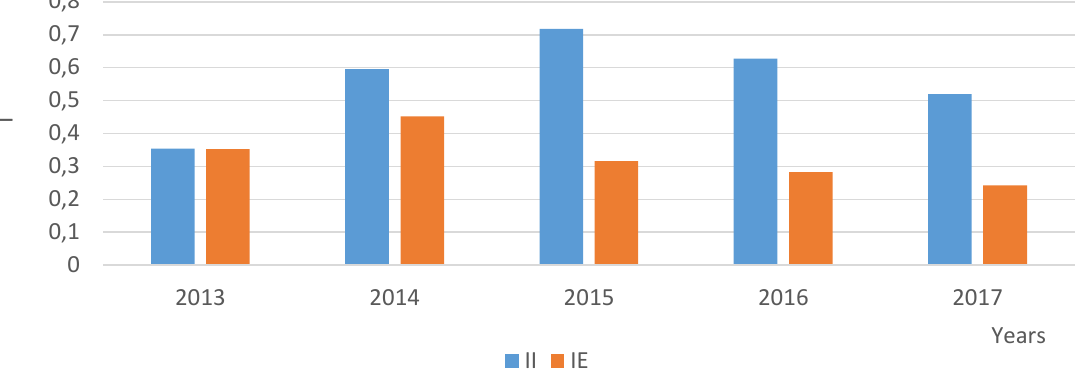
Figure 1. Dynamics of levels of development of export activity (ІЕ) and import activity (ІІ) of the enterprise PAT